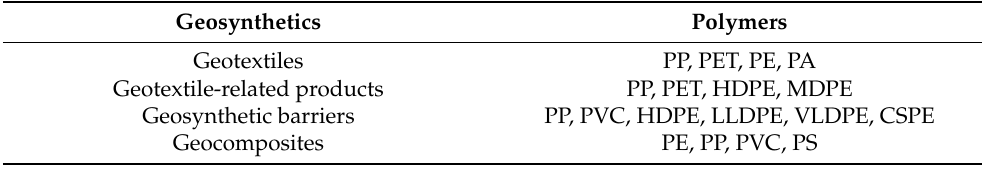
Table 1. Polymers used for geosynthetics manufacturing.